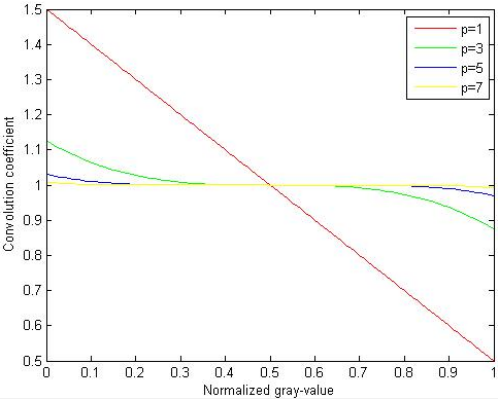
Figure 3. Convolution coefficient function. (2) The q